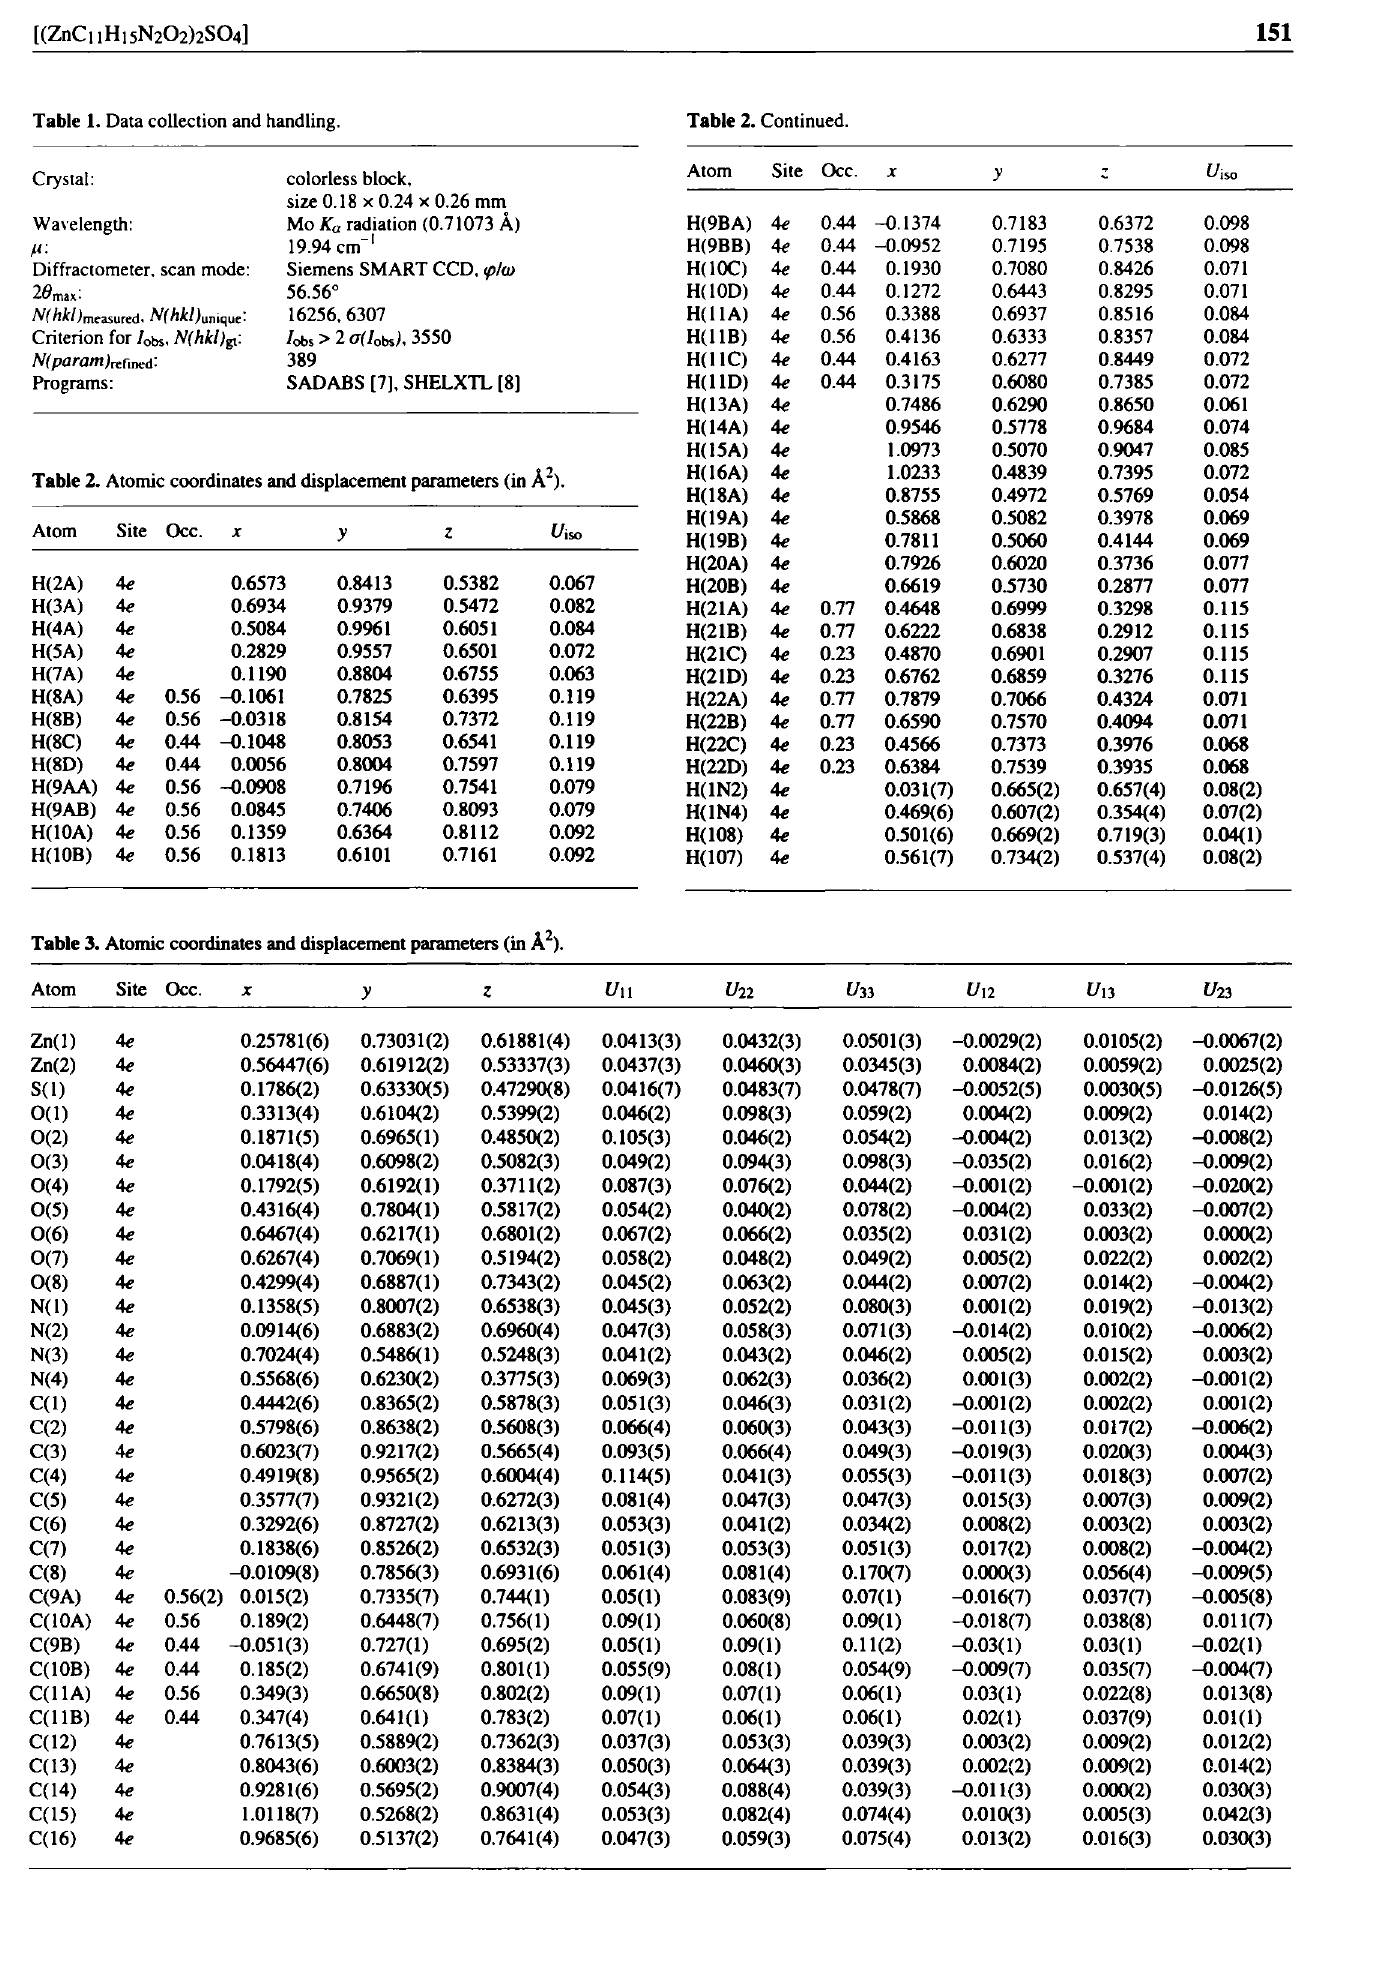
Table 2. Atomic coordinates and displacement parameters (in Â 2 ).